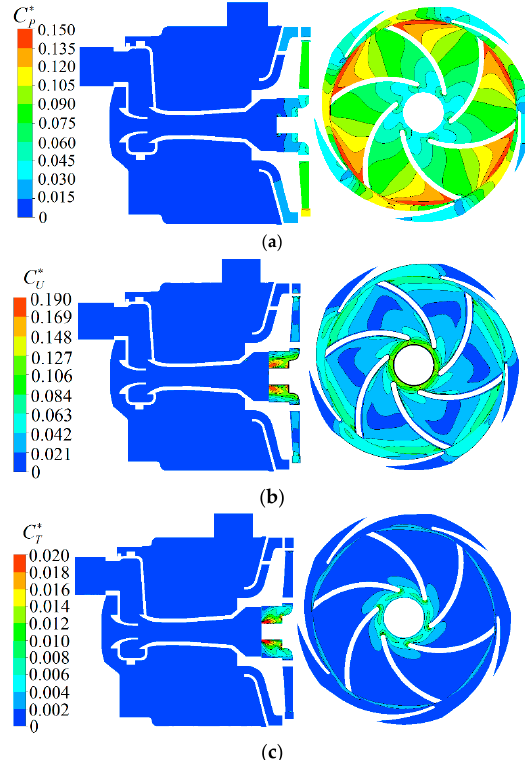
Figure 3. Contour of flow field fluctuation intensity. ( a ) Contour of pressure fluctuation intensity; ( b ) Relative velocity fluctuation intensity; ( c ) Turbulent kinetic energy fluctuation intensity.